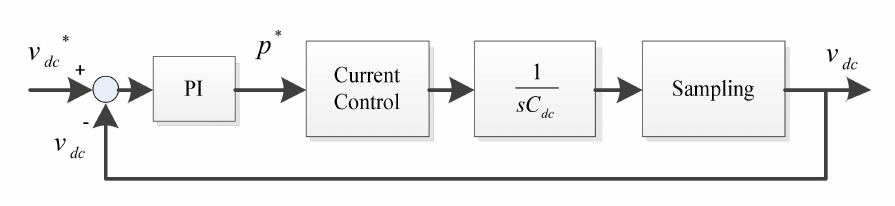
Figure 14. Block diagram of the DC voltage